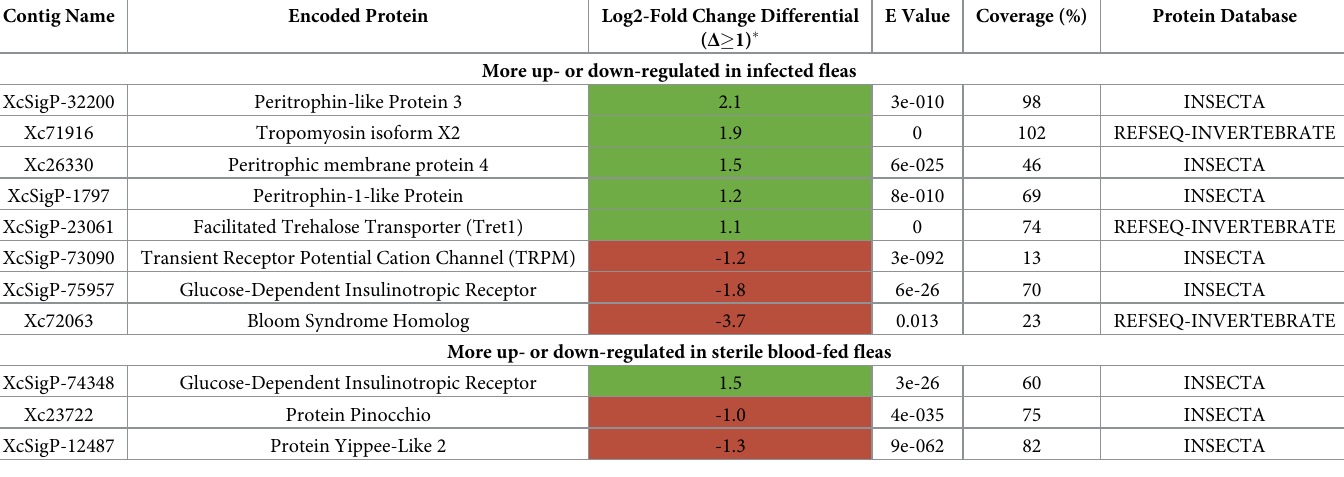
Table 3. Infection-responsive transcripts identified by outlier expression